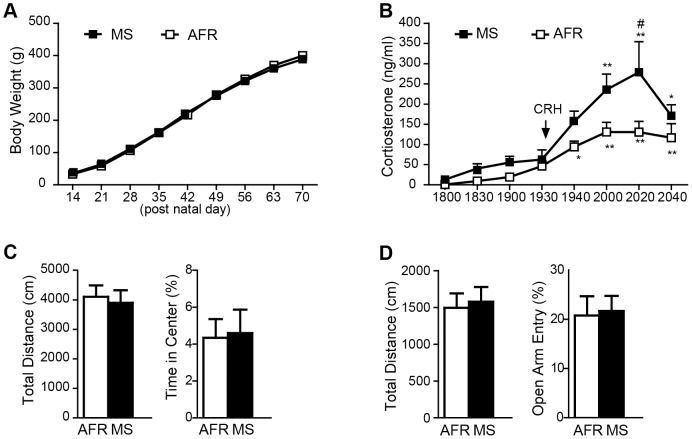
Effect of maternal separation (MS) on body weight, hypothalamic-pituitary-adrenocortical system and anxiety behaviors.
A, Body weight change of rats in MS and animal facility rearing (AFR) groups (MS, n = 22; AFR, n = 17). B, Plasma corticosterone concentrations of MS (n = 8) and AFR (n = 6) rats between 1800 and 2040 h on the dexamethasone/corticotropin-releasing hormone (DEX/CRH) test. All rats were pretreated with DEX (30 µg/kg i.v.) at 1200 h and administered with CRH (50 ng/kg i.v.) at 1931 h. MS rats showed significant increases in plasma corticosterone levels (#p<0.05 vs AFR rats, *p<0.05, **p<0.01 vs baseline). C, Open field test. Total distance and % time in center during the 30 min test were analyzed. D, Elevated plus maze test. Total distance and % number of open arm entries during the 5 min were analyzed. Error bars represent SEM.